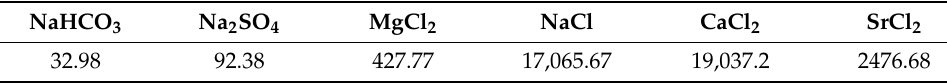
Table 2. Composition of the flow loop test solution